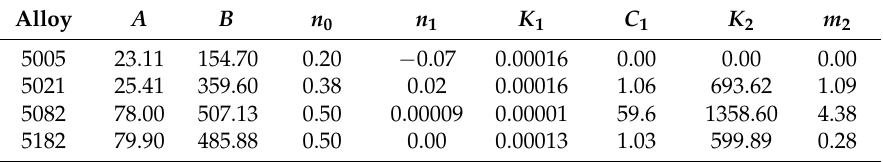
Table 3. Obtained parameters of Equation (8) in 5xxx series aluminum alloys.